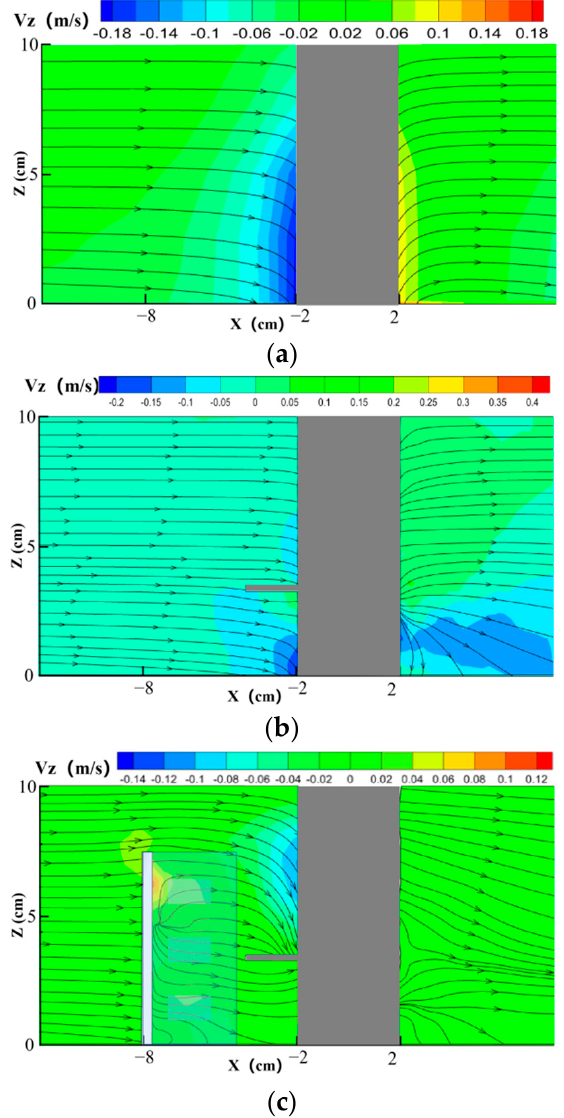
Figure 16. Streamlines and velocity contours at Y = 0.